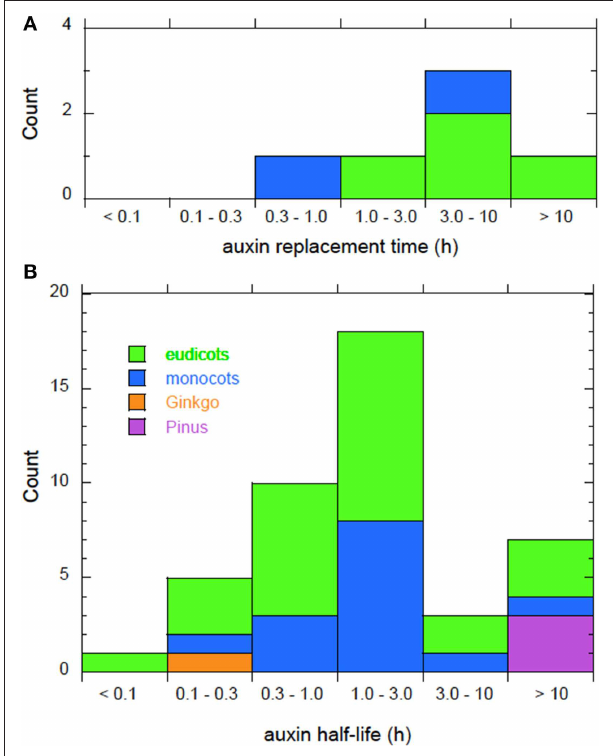
FIGURE 3 | Time scales characterizing auxin metabolism. (A) The replacement time—the time it would take auxin biosynthesis or conjugate hydrolysis to replace the current auxin content of the plant or tissue. (B) The half-life—the time it would take catabolism or conjugation to reduce the current auxin content by 50%. Histograms compiled from data in Tables S1 and S2